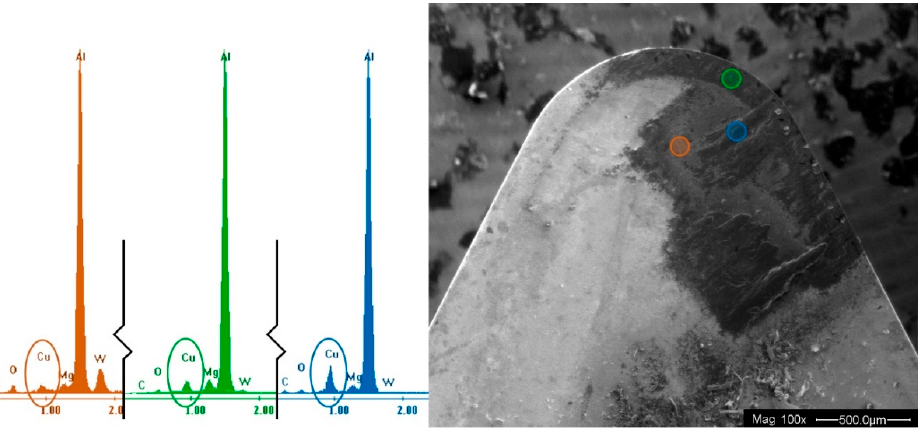
Figure 8. SEM and EDS analyses of the tool after 10 s machining at Vc = 100 m/min, f = 0.1 mm/rev, d = 1 mm.